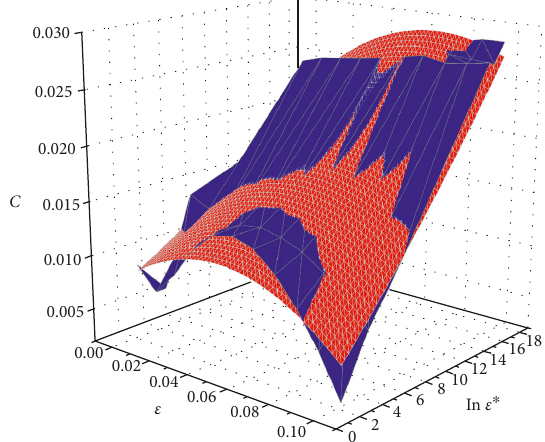
Figure 10: Nonlinear surface fitting of the quadratic polynomial regression